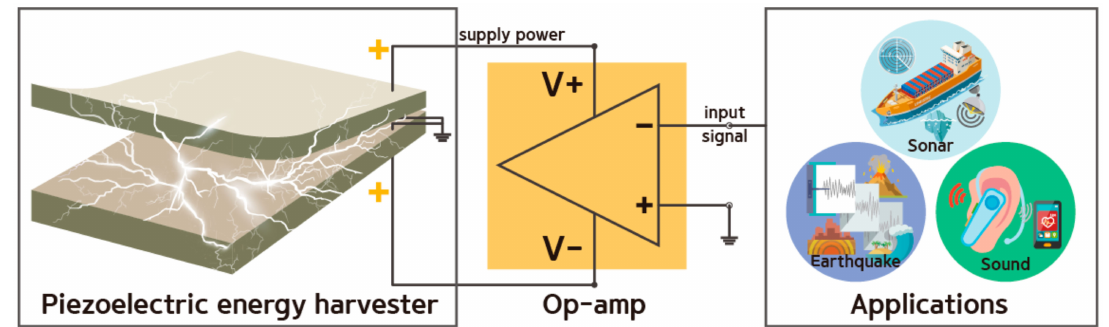
Figure 1. Conceptual design of a self-powered operational amplifying system with a bipolar voltage